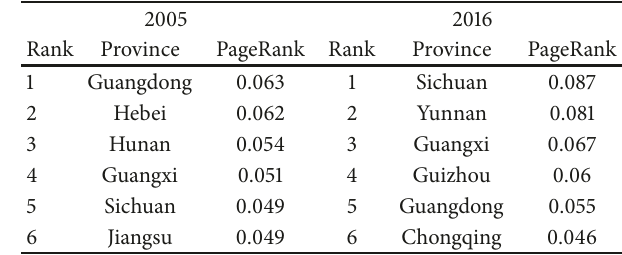
Figure 4: Top-ranked provinces in 2005-2016 based on Hub. Table 4: Top-ranked provinces in 2005 and 2016 based on Hub. Table 5: Top-ranked provinces in 2005 and 2016 based on PageR-